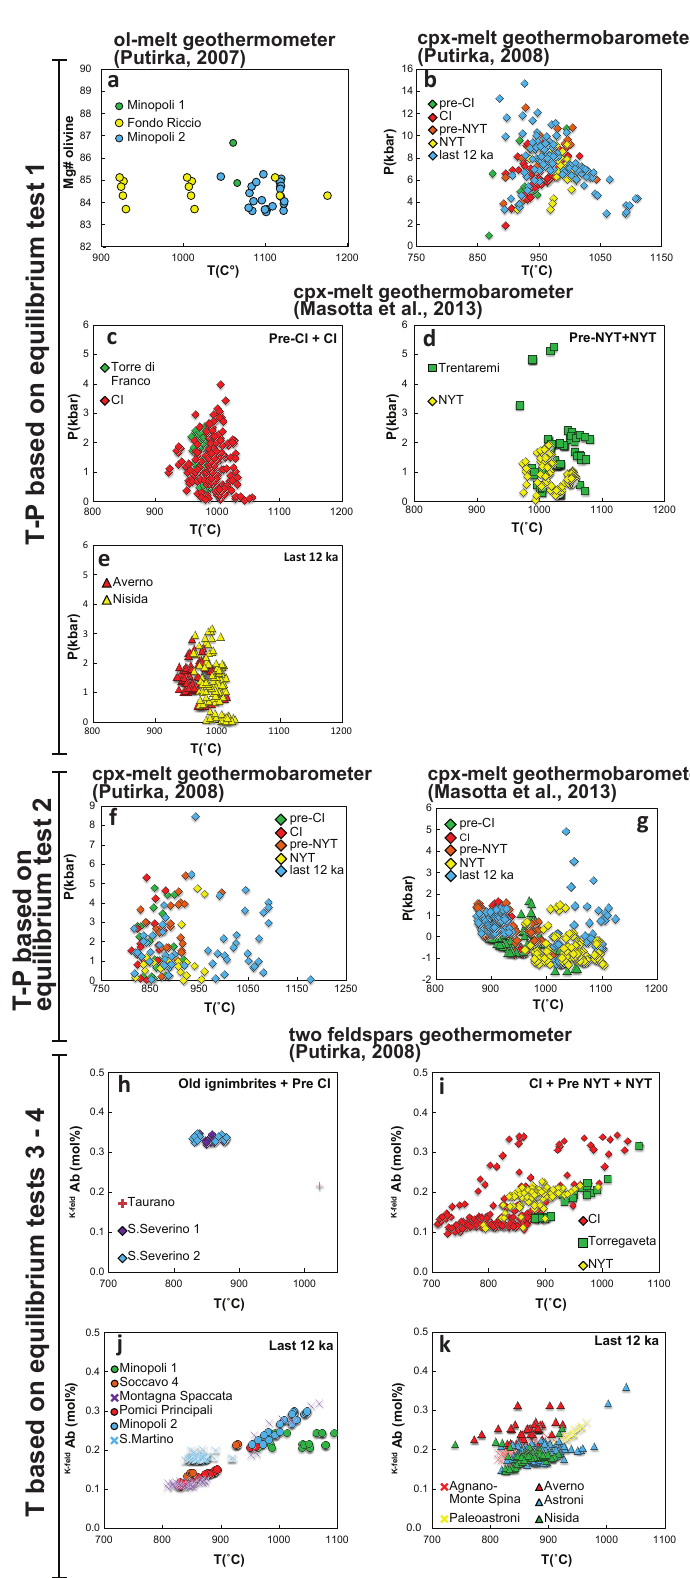
Figure 11. Temperature and pressure output results obtained for the Campi Flegrei minerals through the use of different combinations of geothermobarometric methods and equilibrium tests: ( a ) Mg# vs. T output of the olivine-melt geothermometer applied to olivine-melt couples whose